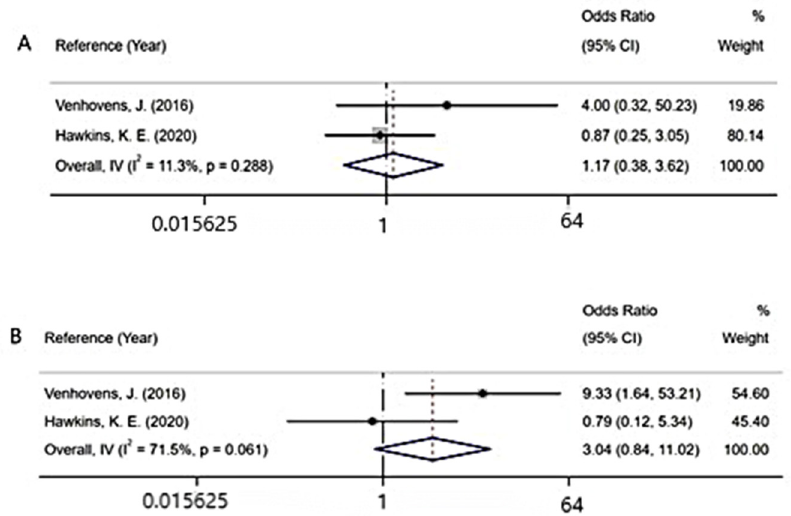
Figure 6. Forest plot of absent VEMP responses in patients with PD who fell within 1 year compared with patients with PD who did not fall within 1 year: ( A ) the absence rate of cVEMP [13,26]; ( B ) the absence rate of oVEMP [13,26].